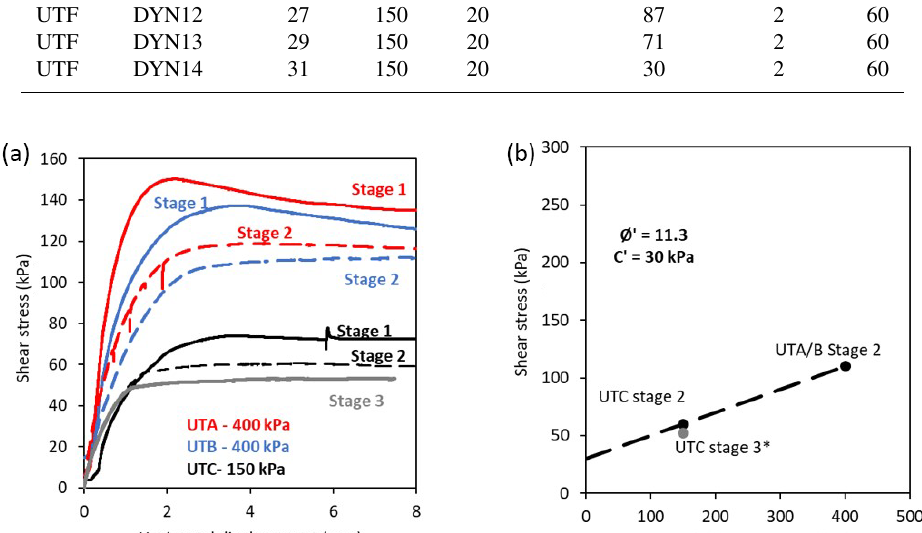
Figure 5. Conventional monotonic drained shear tests. (a) Stress–strain behaviour. (b) Monotonic drained failure